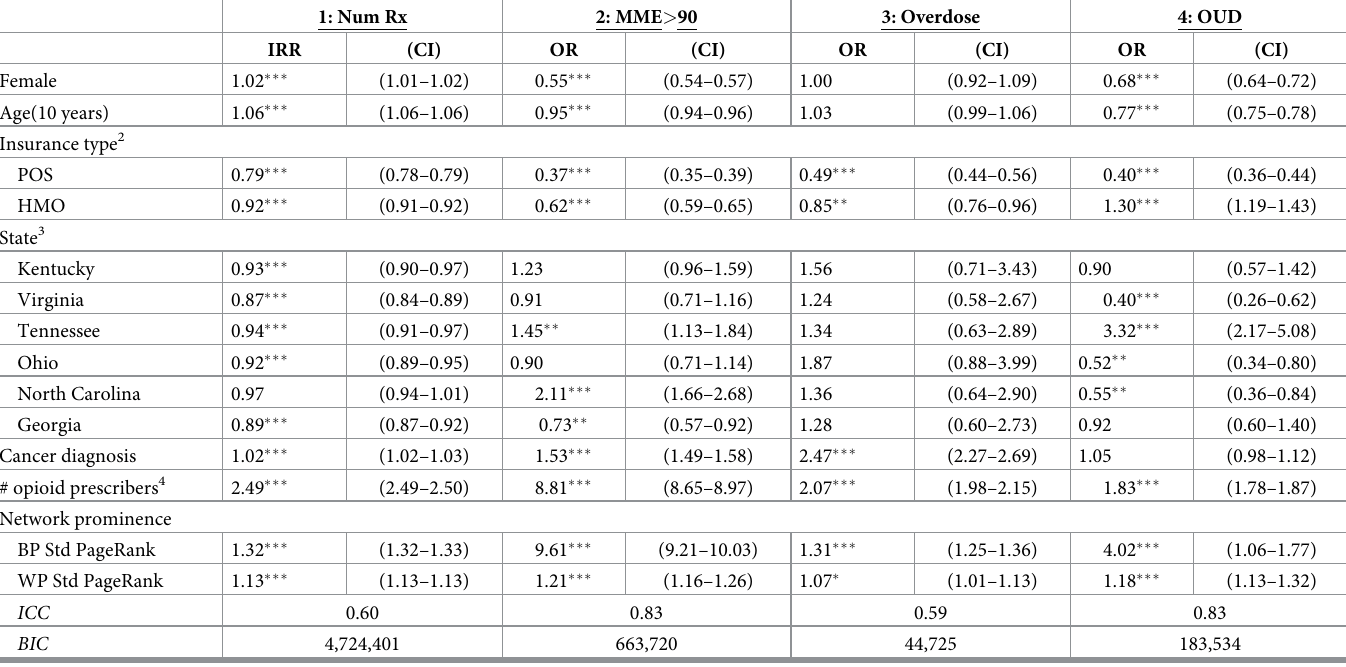
Table 5. Mixed effects regression 1 of opioid outcomes on between-person and within-person patient standardized PageRank and controls (n = 526,914; n obs =